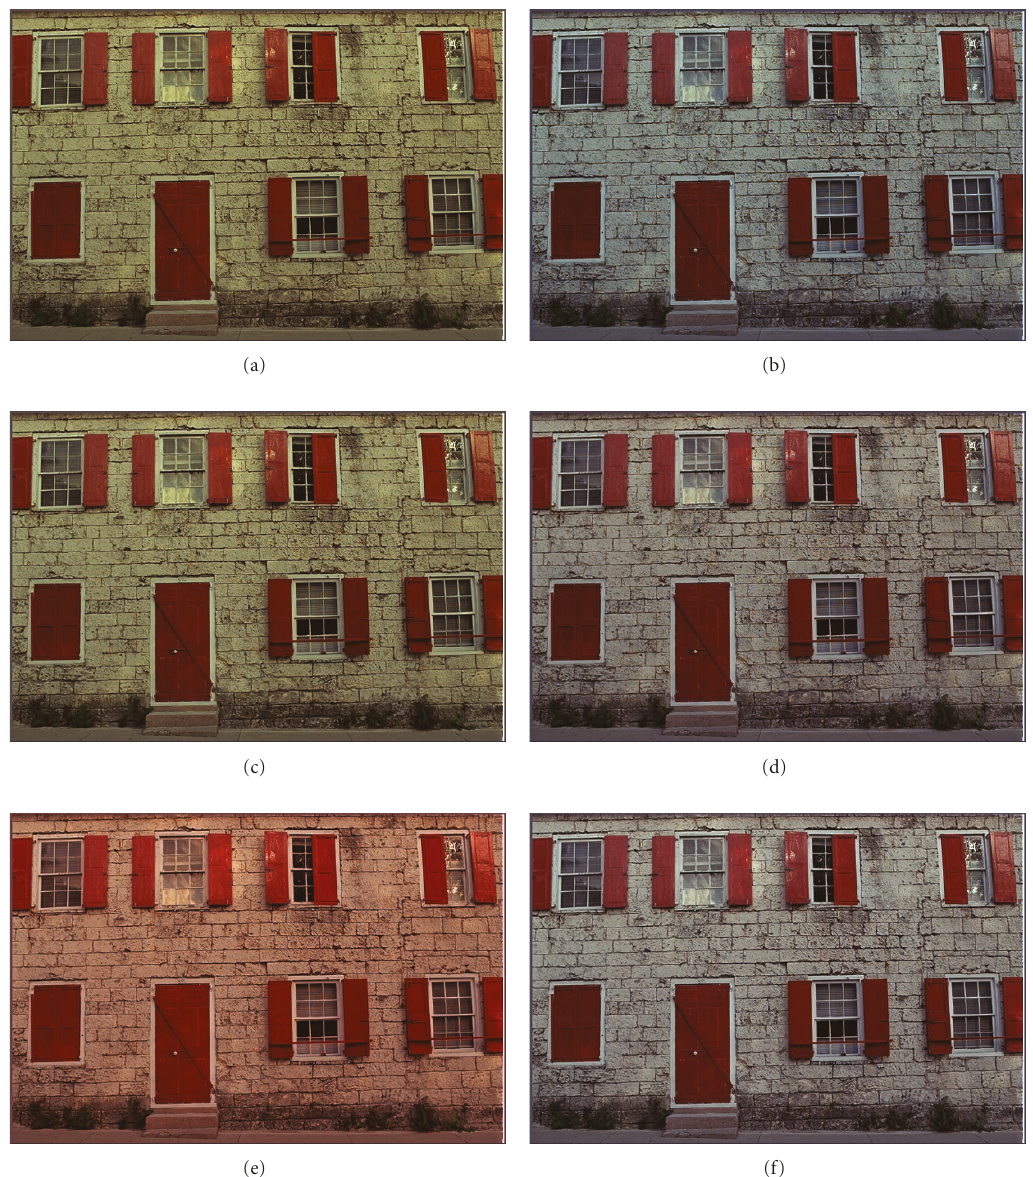
Figure 14: Result of the AWB method: (a) Kodak 1 image, (b) Gray world, (c) Max- RGB , (d) Shades of Gray, (e) Gray Edge, and (f) Proposed